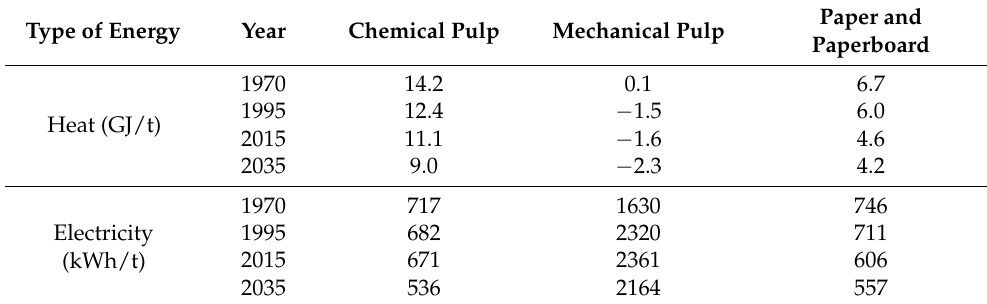
Table 4. An example of development of specific energy consumptions. Estimates were created for the Finnish pulp and paper industry based on Carlson and Heikkinen, and Pöyry [45,46]. Paper and Type of Energy Year Chemical Pulp Mechanical Pulp Paperboard 1970 14.2 0.1 6.7 1995 12.4 − 1.5 6.0 Heat (GJ/t) 2015 11.1 − 1.6 4.6 2035 9.0 − 2.3 4.2 1970 717 1630 746 1995 2320 711 Electricity 2361 (kWh/t) 2035 536 2164